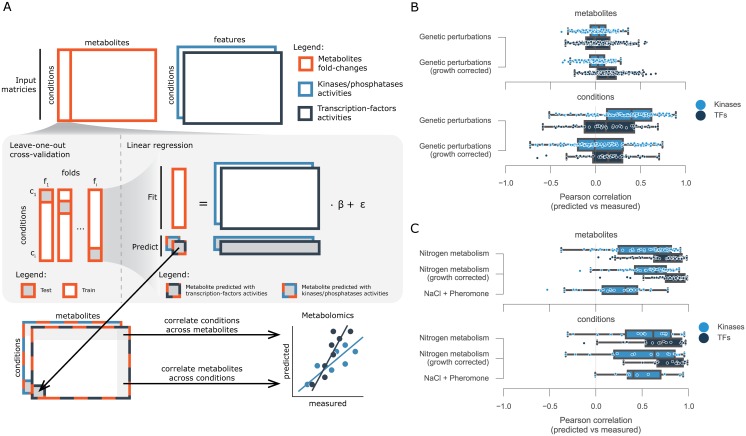
Computational framework for finding associations between protein and metabolites.(A) Diagram of the analysis. For each metabolite measured a multilinear regression analysis was performed using leave-one-out cross-validation. Changes in activity for kinases/phosphatases and transcription factors were used independently to estimate the metabolite fold-change. Independently predicted metabolite fold-change matrices were then correlated metabolite and condition wise with the measured values. Distributions of the correlation values between predicted and measured metabolite fold-changes for the (B) genetic perturbations and for the (C) time-resolved experiments.